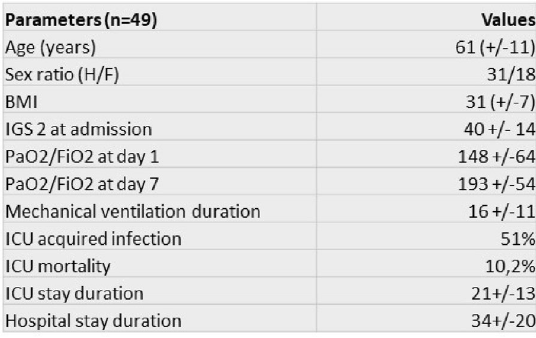
Table: Demographic data and outcomes of patients admitted to intensive care for SARS-CoV-2 associated ARDS. FC‑066 High plasma hyaluronate is associated with mortality in critically‑ill patients with SARS‑CoV‑2 infections BONNY Vincent 1 , URBINA Tomas 1 , ELABBADI Alexandre 2 ,